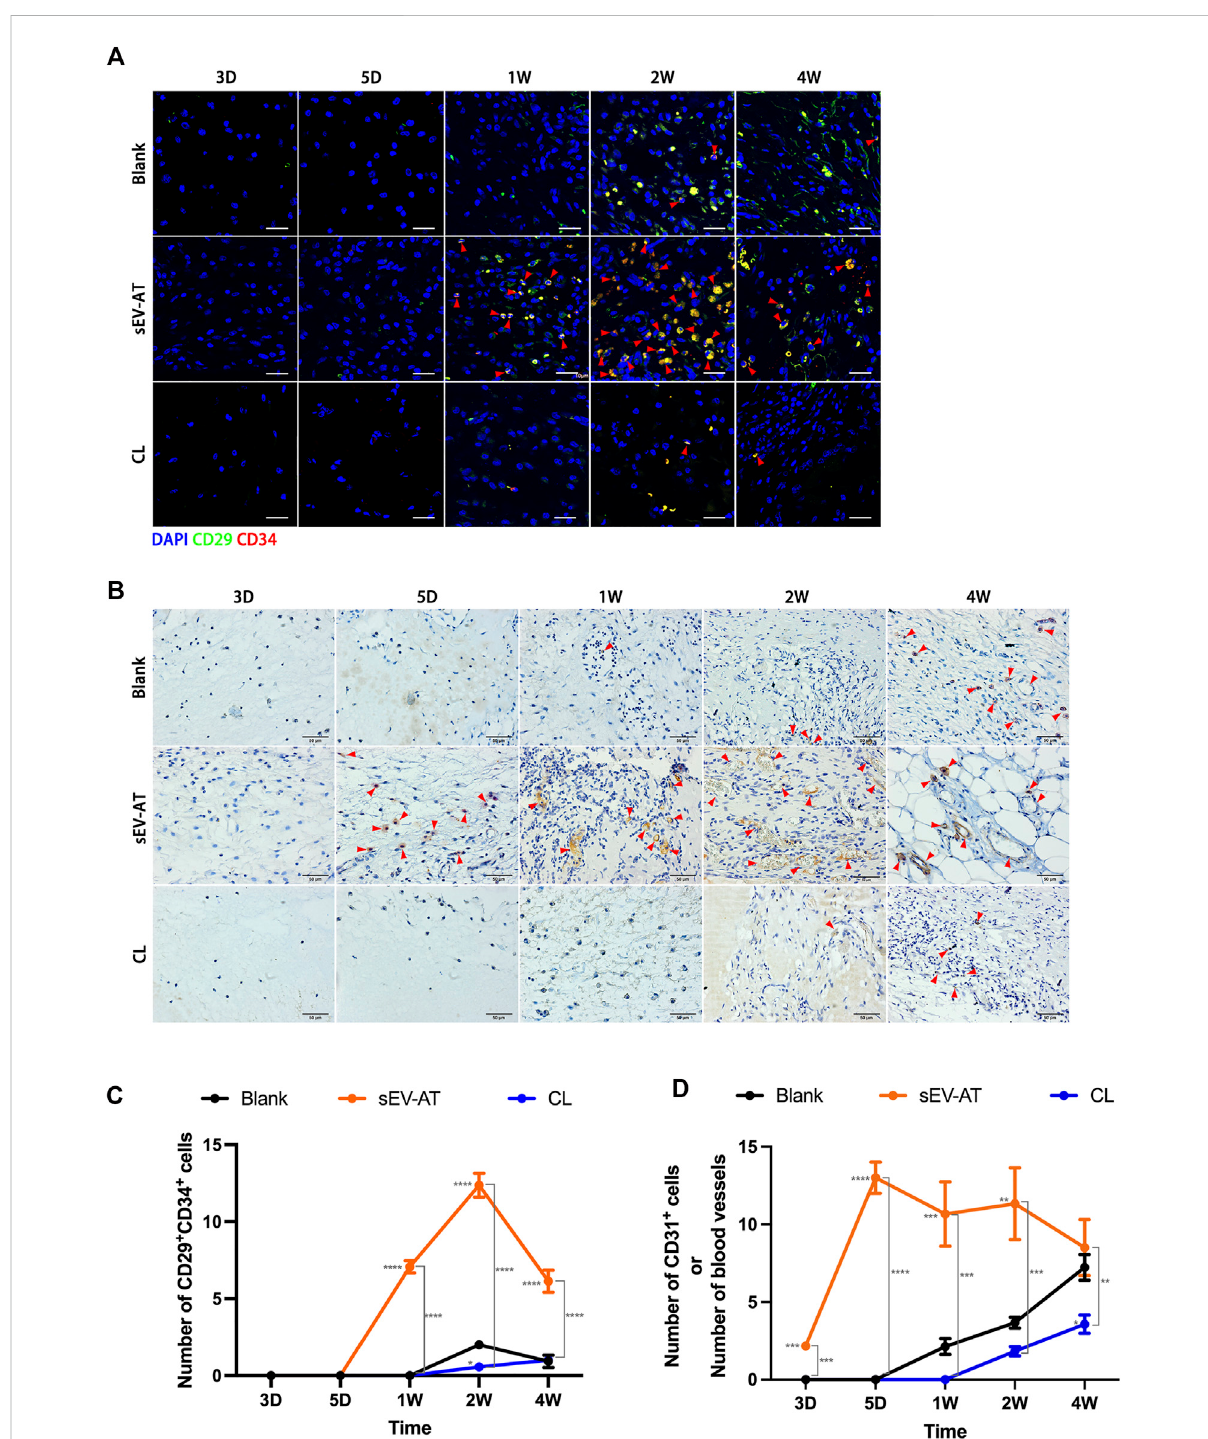
FIGURE 4 The homing of APs and ECs in the implants. (A) Representative anti-CD29 and anti-CD34 Immuno fl uorescence images of the implants (green: CD29, red: CD34, blue: nuclei). The red triangles pointed out typical CD29 + CD34 + cells. Scale bar = 10 µm. (B) Representative anti-CD31 immunohistochemical images oftheimplants. The redtrianglespointed outtypicalCD31 + cells orbloodvessels.Scalebar =50 µm. (C) Thenumber of CD29 + CD34 + APs per fi eld of view (scar bar = 10 μ m) was analyzed (n = 3). (D) The number of CD31 + ECs or blood vessels per fi eld of view (scar bar = 50 μ m) was analyzed (n = 3). The signi fi cance was tested with ordinary one-way ANOVA followed by Tukey ’ s multiple comparisons test. ( */**/***/**** marked beside the data point represented the comparison between the sEV-AT group/the CL group and the blank group, *p < 0.05, **p < 0.01, ***p < 0.001, ****p <